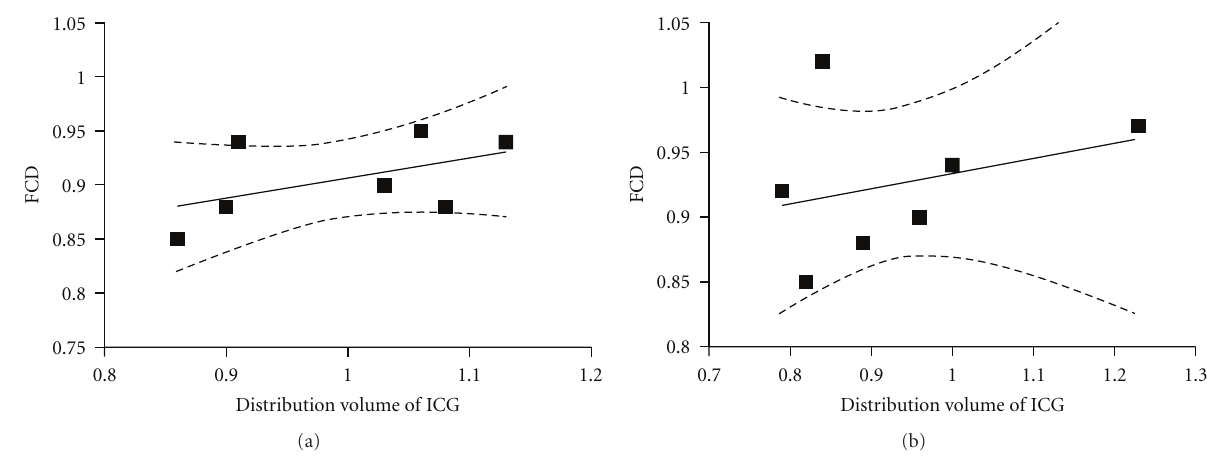
Figure 5: (a): Correlation between functional capillary density (FCD) and the distribution volume of indocyanine green (ICG) at 45 minutes (a) and 120 minutes (b). FCD obtained at 30 minutes was used for the correlation at 45 minutes. The confidence intervals for the regression line (the two dotted lines) indicates the lack of correlation at any of the time points.